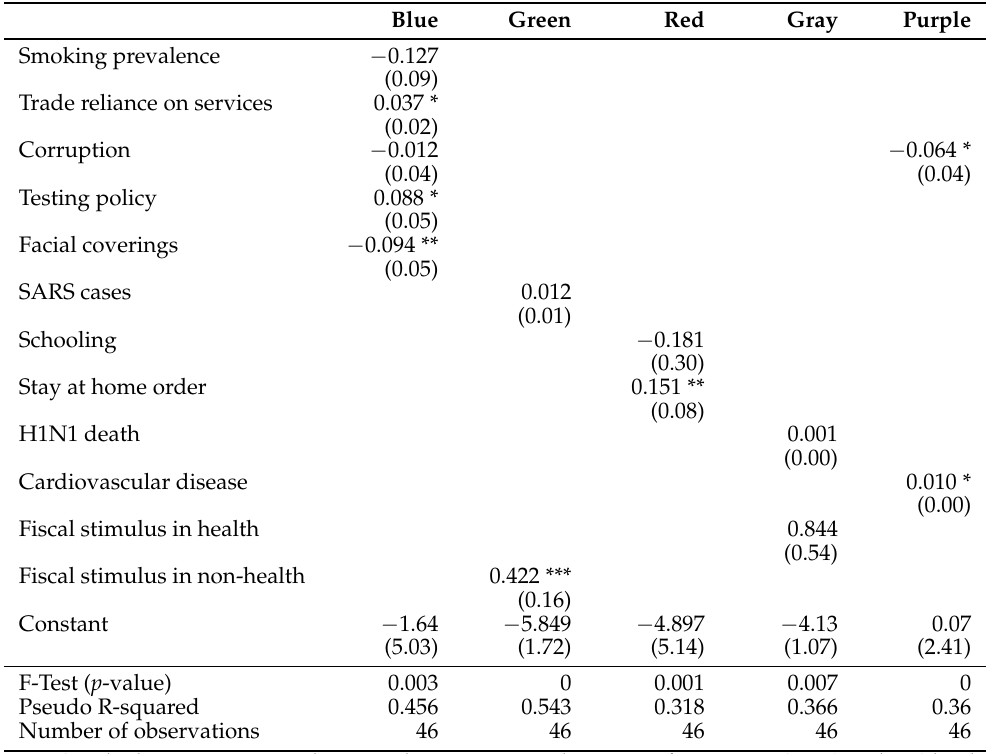
Table 5. Logistic regression results for variables selected by